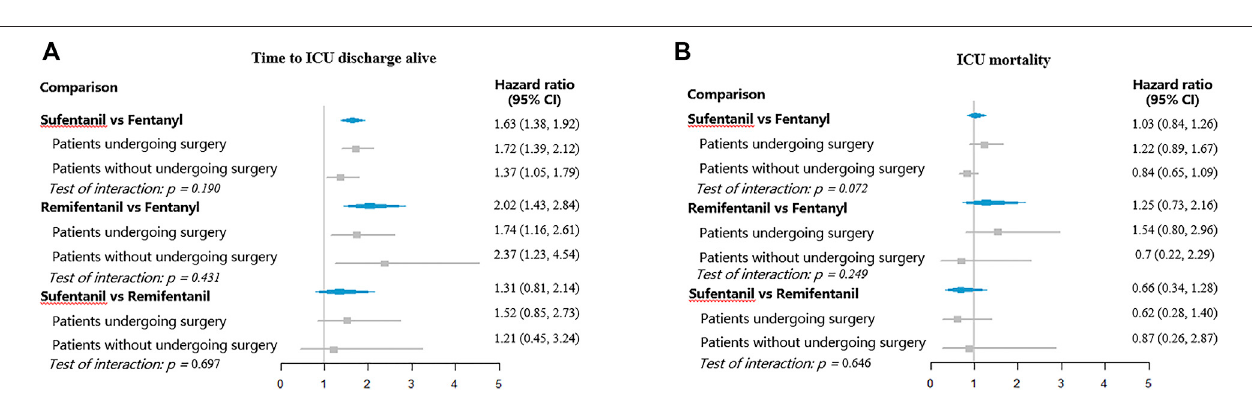
FIGURE 4 | Hazard ratios for ICU discharge and ICU mortality with different opioids. (A) Time to ICU discharge alive; (B) ICU mortality.